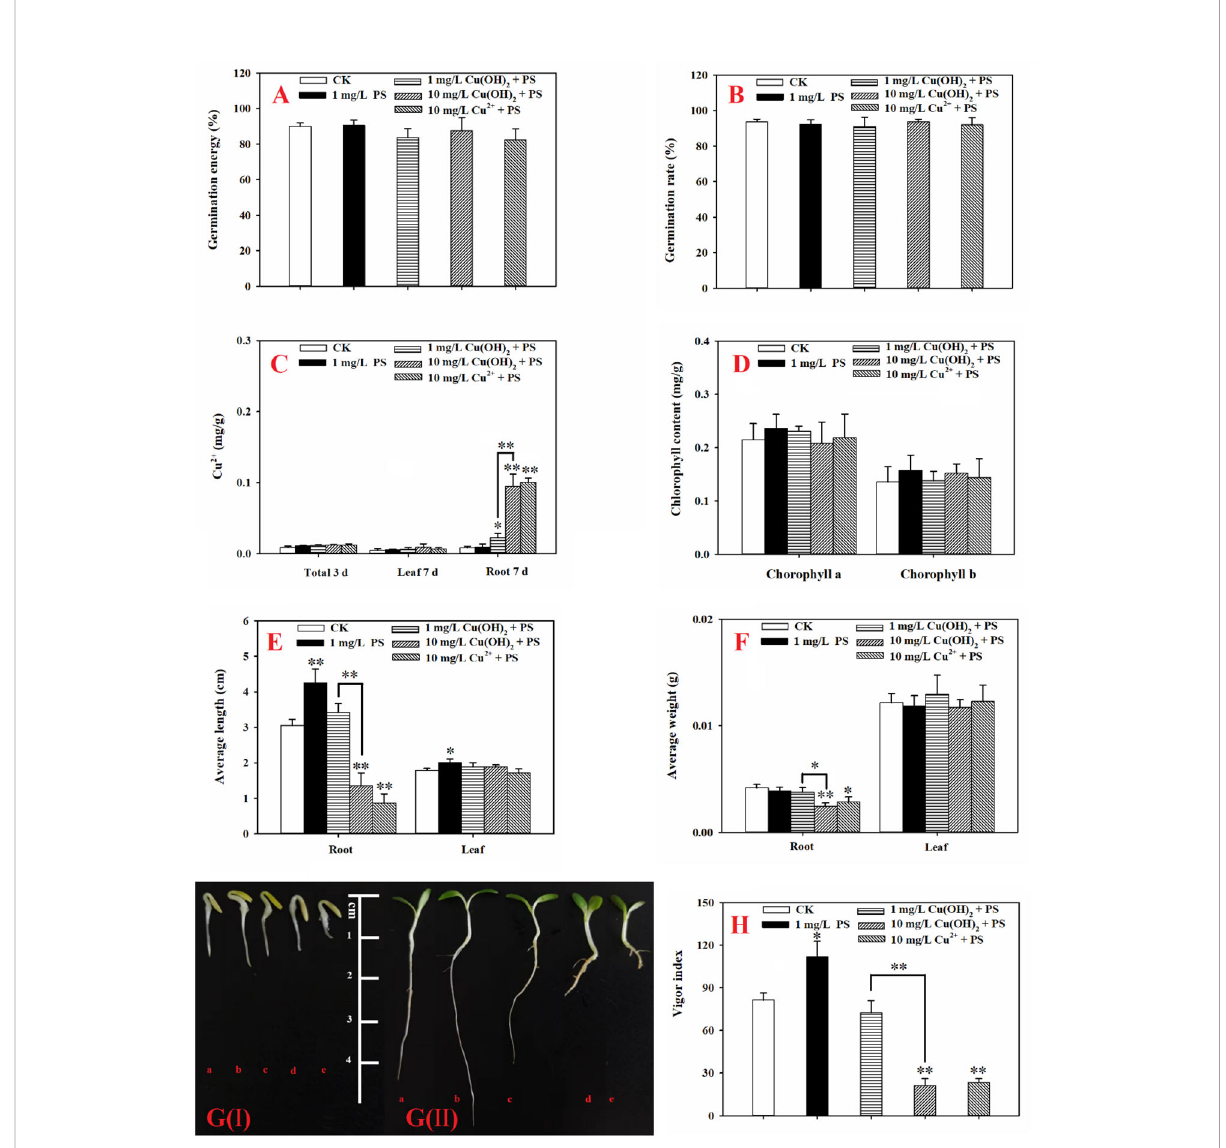
FIGURE 4 (A) : Germination energy of lettuce seeds under different treatments; (B) : germination rates of lettuce seeds under different treatments; (C) : accumulation of Cu in lettuce seeds (3 d) and in seedling leaves and roots (7 d) under different treatments; (D) : chlorophyll content in seedling leaves (7 d) under different treatments; (E) : average length of roots and leaves (7 d) under different treatments; (F) : average weights of roots and leaves (7 d) under different treatments; (G) : lettuce seed germination at 3 d (I) and lettuce seedling growth at 7 d (II). The letters a, b, c, and d denote the control, 1 mg/L Cu(OH) 2 , 10 mg/L Cu(OH) 2 , and 10 mg/L Cu 2+ treatment groups, respectively; and (H) : vigor index of lettuce seedlings (7 d) under different treatments. The data are shown as the mean ± SD from the four replicates and were analyzed with a t test to explore any signi fi cant differences between treatment groups; the asterisks * ( p < 0.05) and ** ( p < 0.01) denote statistical signi fi cance and high statistical signi fi cance,